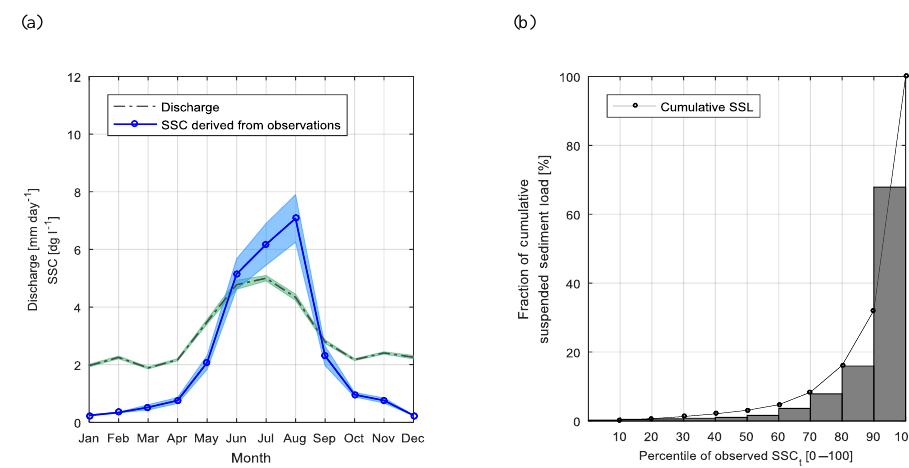
Figure 2. (a) Mean monthly values of discharge measured at the outlet of the catchment (dash–dot grey line) and SSC t derived from observations of NTU (solid blue line with circles). Coloured shaded areas represent the range corresponding to ± standard error. Mean values and standard errors are computed over the entire observation period. (b) Cumulative suspended sediment load (SSL) transported at the outlet of the upper Rhône Basin during the observation period as function of different percentiles of SSC t (black line with circles). Bars represent the fraction of the total SSL transported by the different percentiles of SSC t (e.g. more than 66% of total SSL is transported with SSC t > 90th percentile).